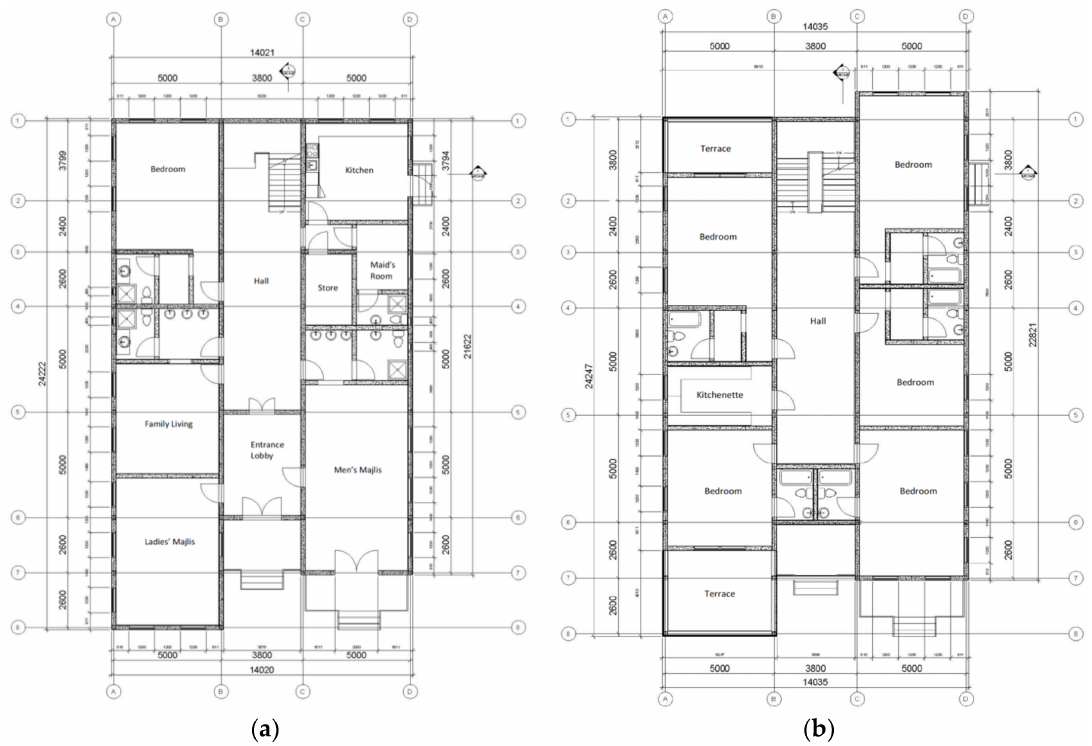
Figure 4. Adjusting modularity of the 5-bedroom ‘complete’ house to conform with the dimensions of the selected SIP system: ( a ) GF Plan, ( b ) 1st F